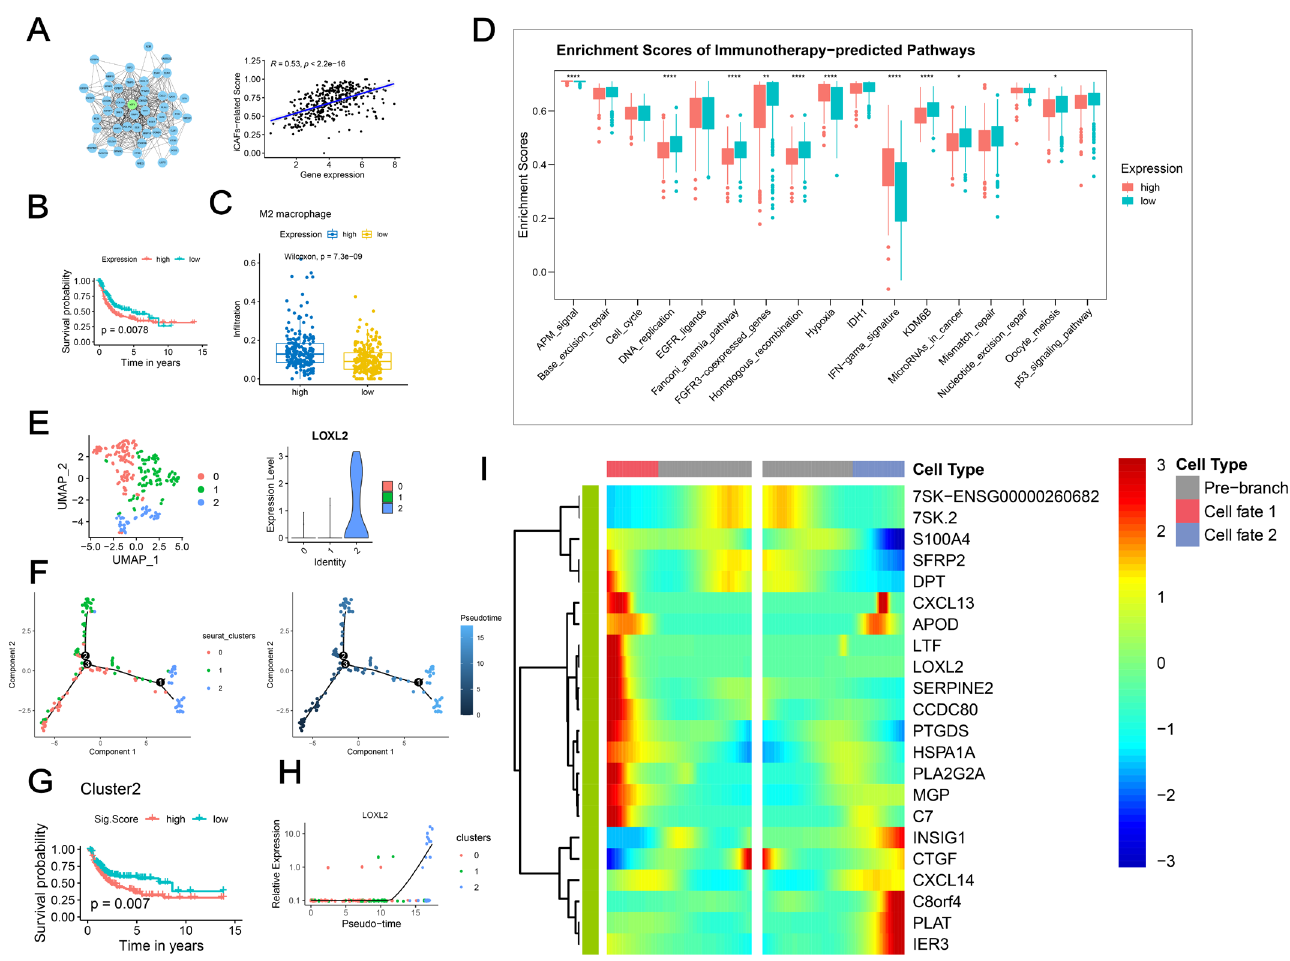
Figure 5. LOXL2+ iCAFs predicted poor prognosis: ( A ) Hub gene LOXL2 was identified by analyz- ing the PPI network. ( B ) High expression of LOXL2 was associated with poor prognosis. ( C ) The infiltration level of M2 macrophage was significantly higher in the overexpressed LOXL2 group. ( D ) Highly expressed LOXL2 was related to several downregulated immunotherapy-predicted path- ways. * p < 0.05; ** p < 0.01; **** p < 0.0001. ( E ) Re-clustering of iCAFs identified three subpopulations and LOXL2 was highly expressed in subcluster 2. ( F ) Pseudotime analysis demonstrated that sub- cluster 0 was projected onto the root while subcluster 1 and 2 were projected onto two branches, respectively. ( G ) Subcluster 2 was related to a worse prognosis. ( H ) LOXL2 expression level varied dramatically with the trajectory tree. ( I ) Heatmap demonstrated the branch-dependent